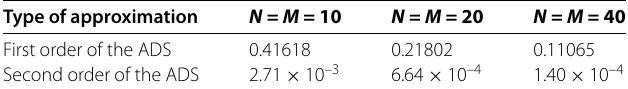
Table 6 Error of p in example